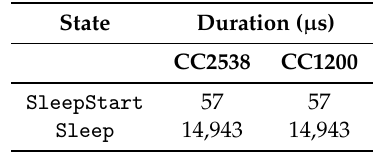
Table 9. State durations in the Sleep time slot with a total length of